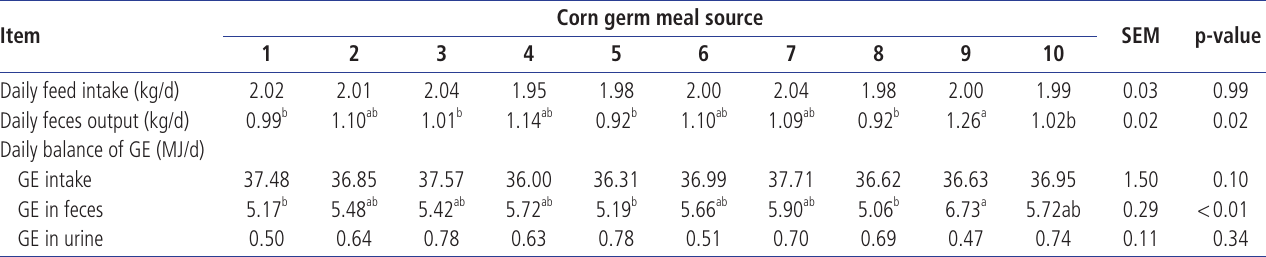
Table 4. The daily feed intake, daily feces output and daily balance of GE for growing pigs fed corn germ meal diets 1)